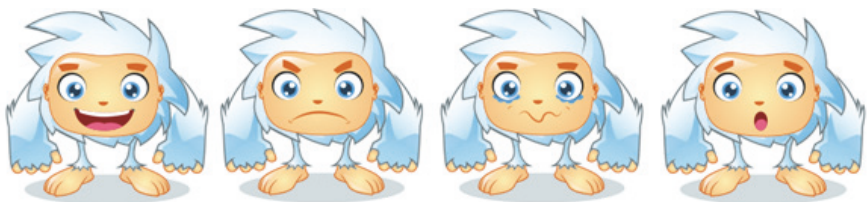
Figure 8: Character emotion, variation of the facial expressions [23].